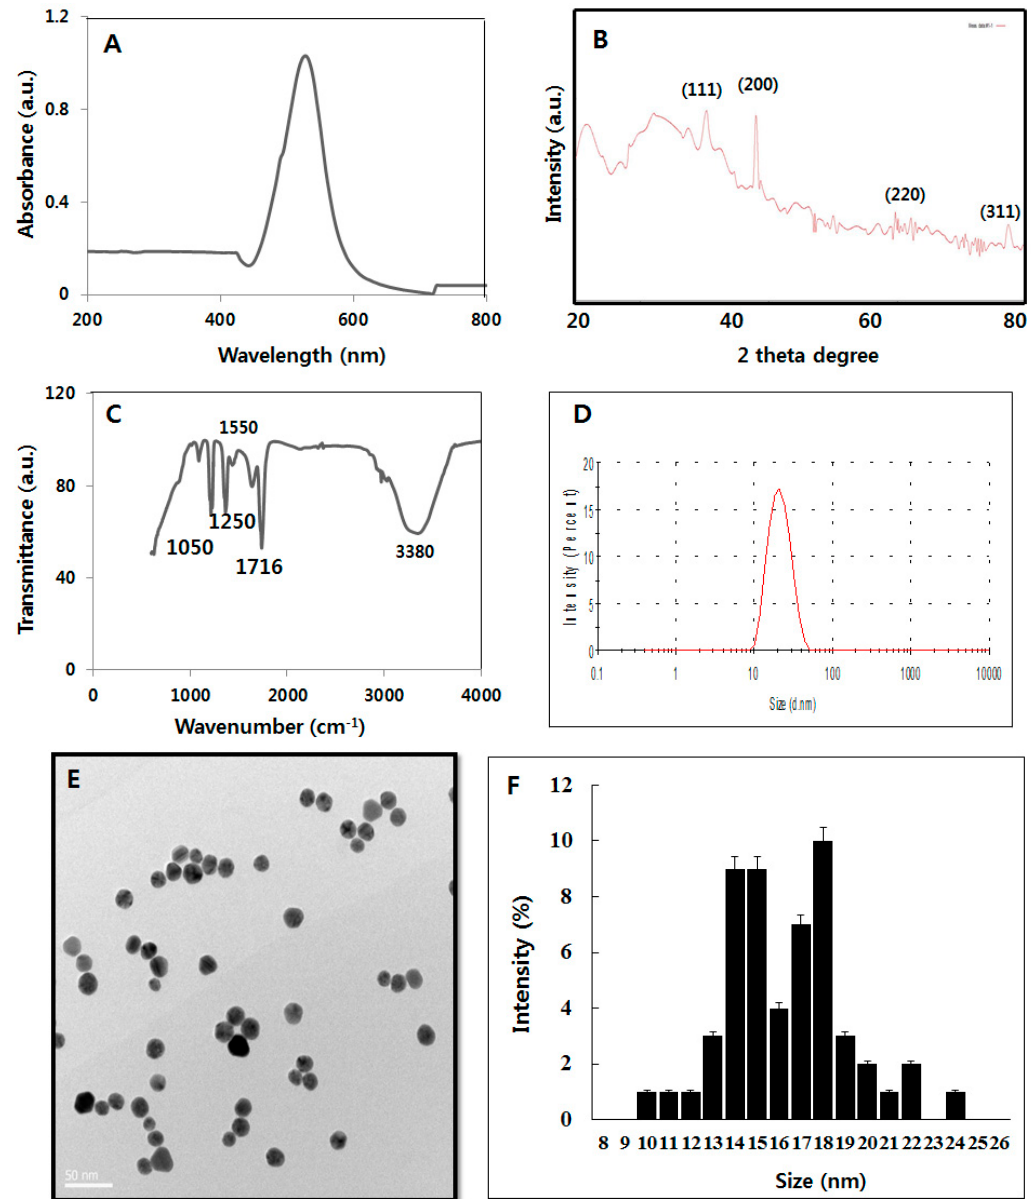
Figure 1. Synthesis and characterization of AuNPs using luteolin. Synthesis of AuNPs was performed by incubating luteolin (20 μ M) and 1 mM aqueous HAuCl 4 at 40 °C for 2 h. ( A ) Ultraviolet-visible spectroscopy of AuNPs revealed a maximum absorption peak at approximately 530 nm. This band was assigned to surface plasmon resonance of the particles; ( B ) XRD images of AuNPs; ( C ) Fourier transform infrared images of AuNPs; ( D ) Dynamic light-scattering (DLS) spectra of dispersions of AuNPs; ( E ) TEM images showing the size and shape of AuNPs; ( F ) Particle size distribution from TEM images. At least 200 particles were measured for each sample to obtain the size distribution. The average diameter was 18 nm. At least three independent experiments were performed for each sample and reproducible results were obtained. The data present the results of a representative experiment.